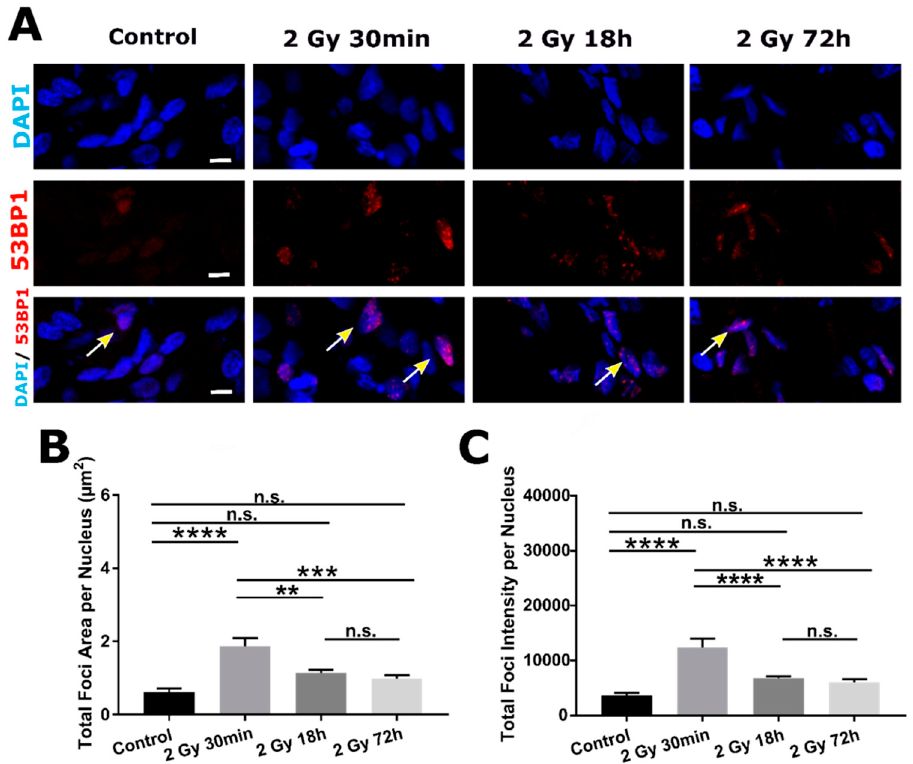
Figure 3. Profile of DSB DNA damage response of SOX2 − cells at early (30 min) and later time-point (18 and 72 h) following 2 Gy irradiation, visualized by 53BP1 DSB maker. ( A ) Representative images of nuclei (DAPI, first row) that are positive for the presence of DSBs, with 53BP1 antibody (red foci, second row; yellow arrows pointing at nuclei with 53BP1 + foci on merged images, third row) of Control and 2 Gy irradiated organoids (30 min, 18 and 72 h post-irradiation). Total foci area ( B ) and total foci intensity ( C ) per nucleus are both highest 30 min following 2 Gy irradiation, followed by significant decrease of both parameters in later time points compared to Control values (data are represented as bar charts showing foci signal mean values. N = 3 organoids per group, n = 30 ROIs per group, total amount of DAPI + cells analyzed per group n ~ 2000). Scale bar 5 µm. ** p < 0.01, *** p < 0.001, **** p < 0.0001, n.s.—non-significant (one-way ANOVA, followed by Tukey’s multiple comparisons test).